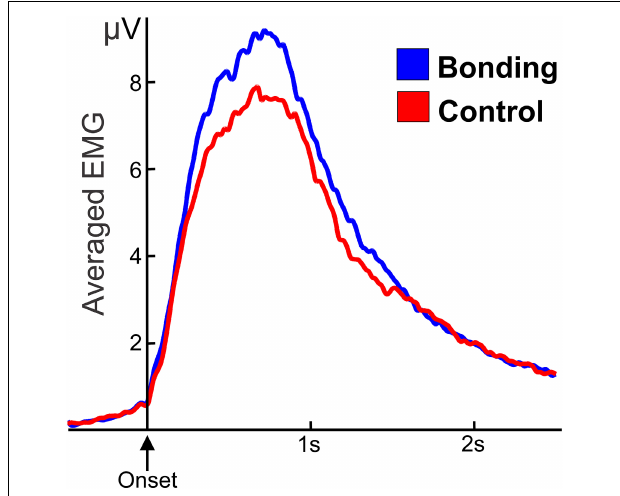
FIGURE 3 | Averaged and smoothed electromyographic activity (potentials in μ V) of fingers flexor during the caressing of the soft cloth. In the “bonding” (blue) condition activity is higher than in the “control” (red) condition. Zero in the abscissa represents movement